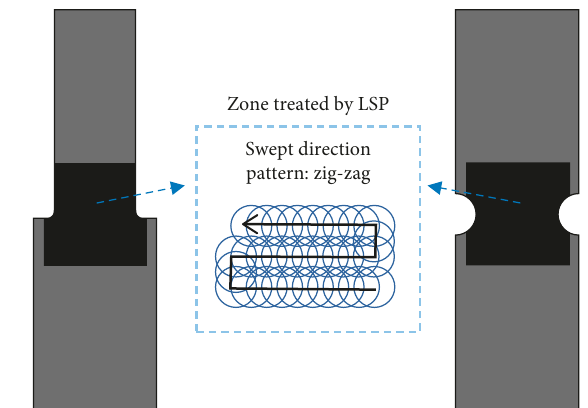
Figure 4: LSP Pulse sequence.